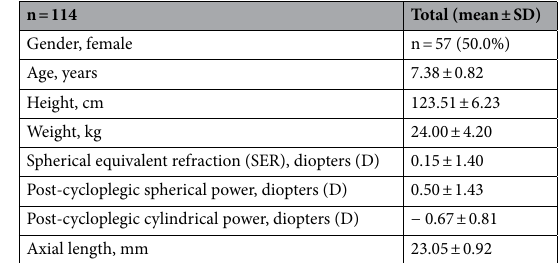
Table 1. Demographics of subjects. SD standard deviation, SD-OCT spectral-domain optical coherence tomography, SS-OCT swept-source optical coherence tomography.